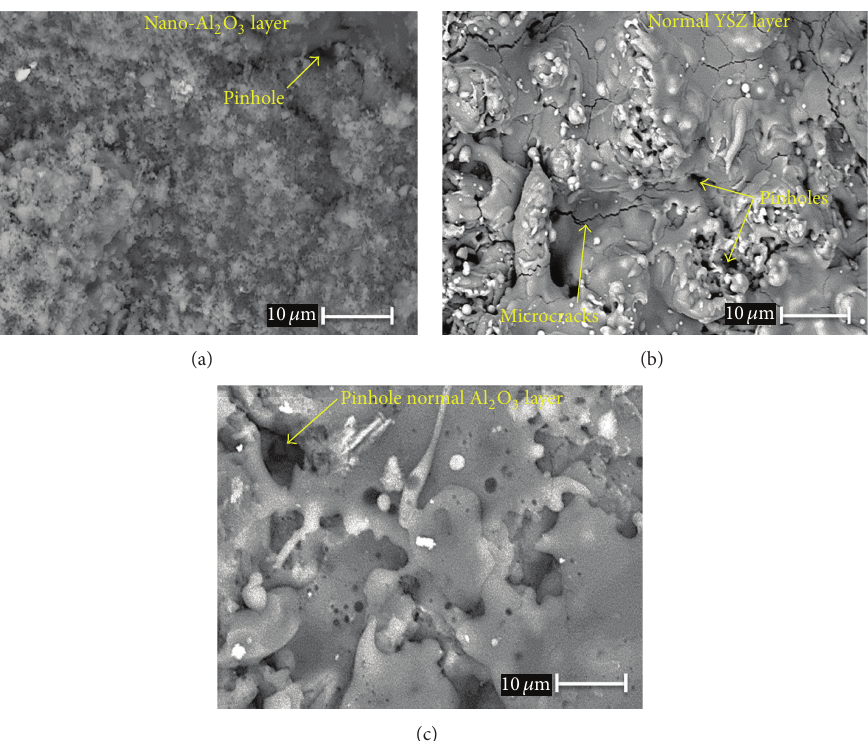
Figure 6: Surface morphology of the as-sprayed coatings with high magnification: (a) nanostructured Al 2 O 3 layer, (b) normal YSZ layer, and (c) normal Al 2 O 3 layer.